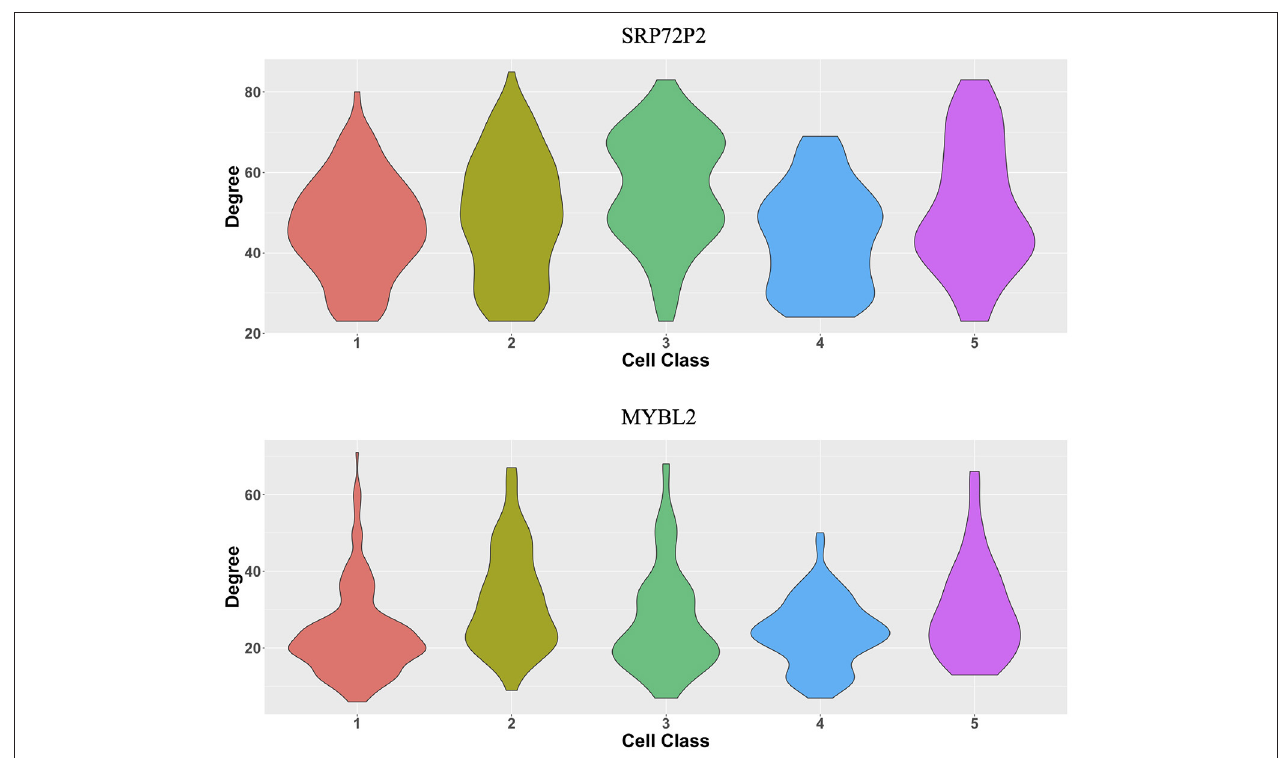
FIGURE 9 | Violin plots of two genes’ degree distributions across five cell classes in the MERFISH U-2 OS cell line